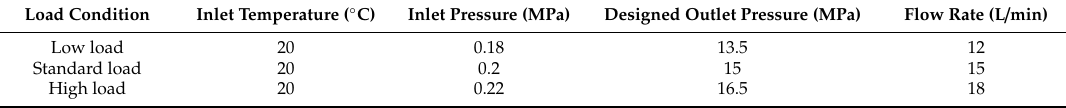
Table 6. Experiments for testing the technical